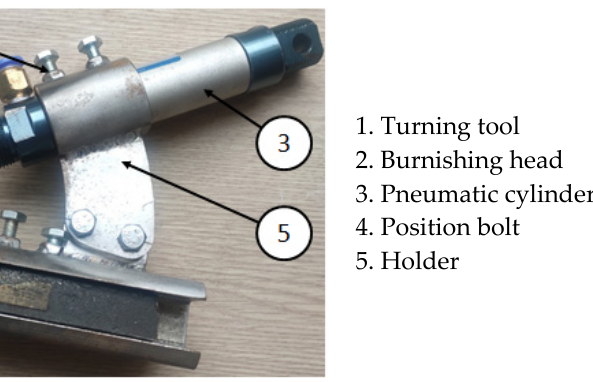
Figure 1. A new hybrid turning-burnishing tool.